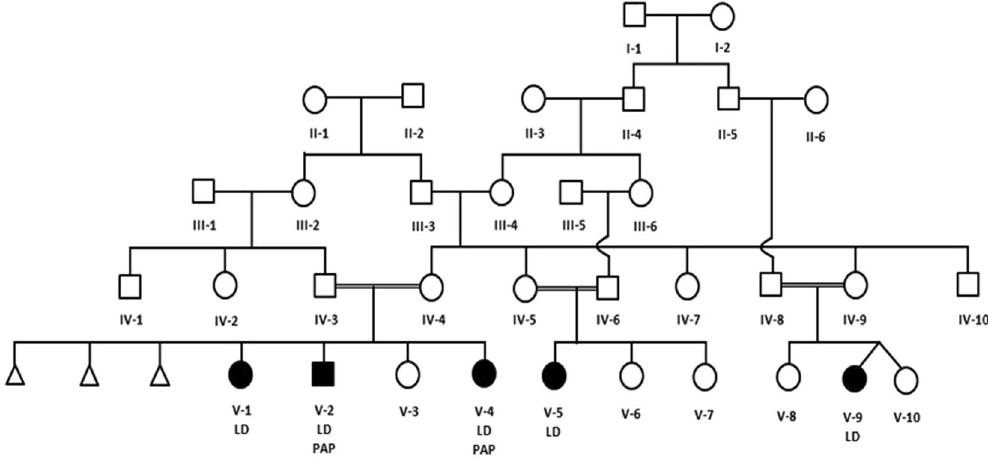
Figure 1. Pedigree diagram illustrating consanguinity. DNA samples from one branch of the family (from parents IV-3 and IV-4) with three affected children (V-1, V-2 and V-4) and one healthy child (V-3) were analysed. LD = Learning Disability. PAP = Postaxial Polydactyly.